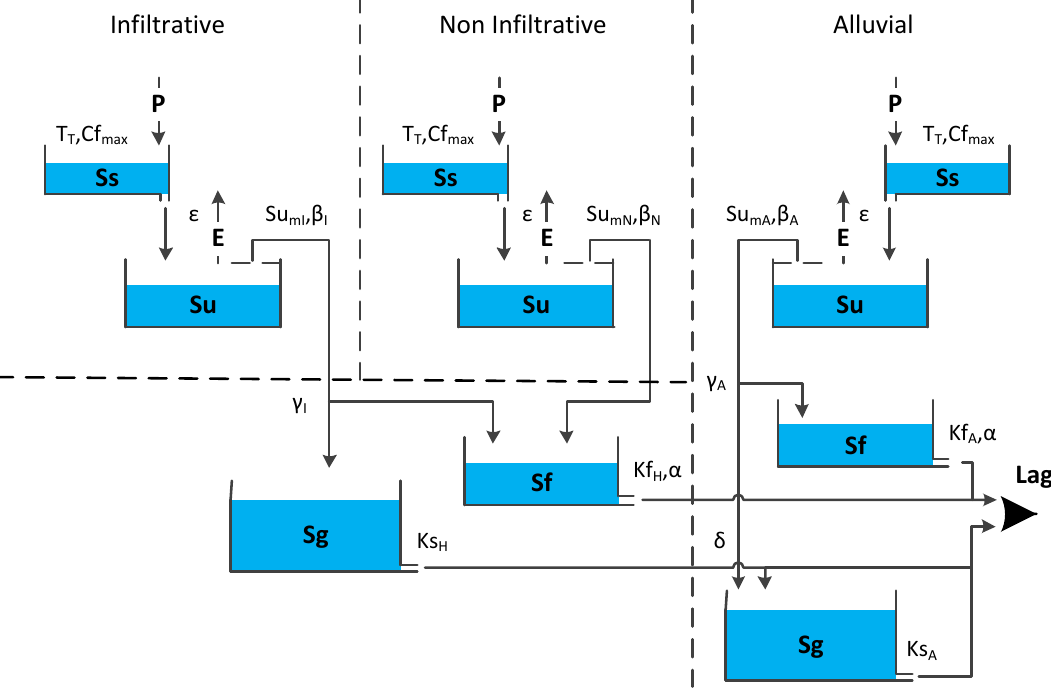
Figure 5. Setup of the rainfall–runoff model based on the three main land classes in northern Iraq. The upper three reservoirs (Ss) represent the snow accumulation in the basin based in precipitation and temperature. The second layer of three reservoirs (Su) represent the water storage in the unsaturated zone and routes runoff to the fast runoff (Sf) and groundwater (Sg) reservoirs. The third layer of two reservoirs (Sf) represent the water storage related to fast runoff processes, which consist of overland flow and interflow. The two bottom reservoirs represent the groundwater storage, which is the main focus in this study. The water fluxes, indicated with arrows, are calculated based on reservoir levels and model